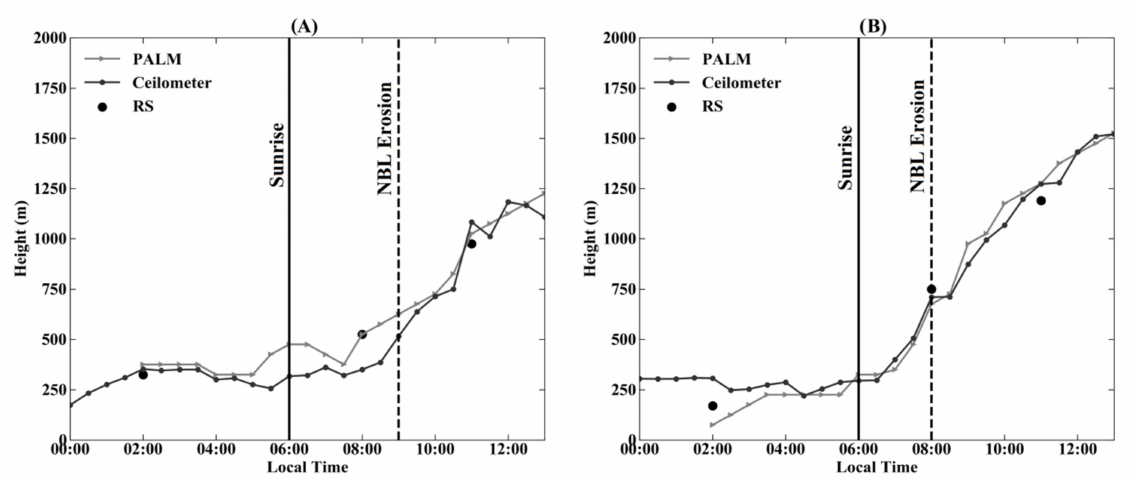
Figure 4. Heights of the PBL over the GoAmazon site for ( A ) IOP 1 and ( B ) IOP 2. The vertical lines mark sunrise (continuous line) and the erosion of the NBL (dashed